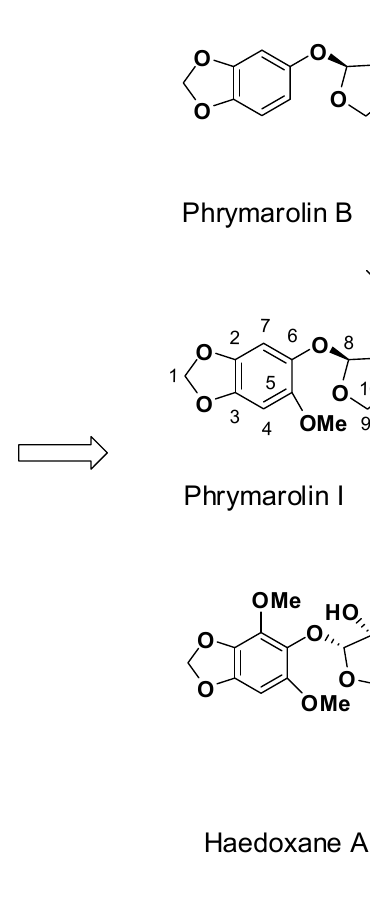
Figure 1. Phryma leptostachya L. and its characteristic